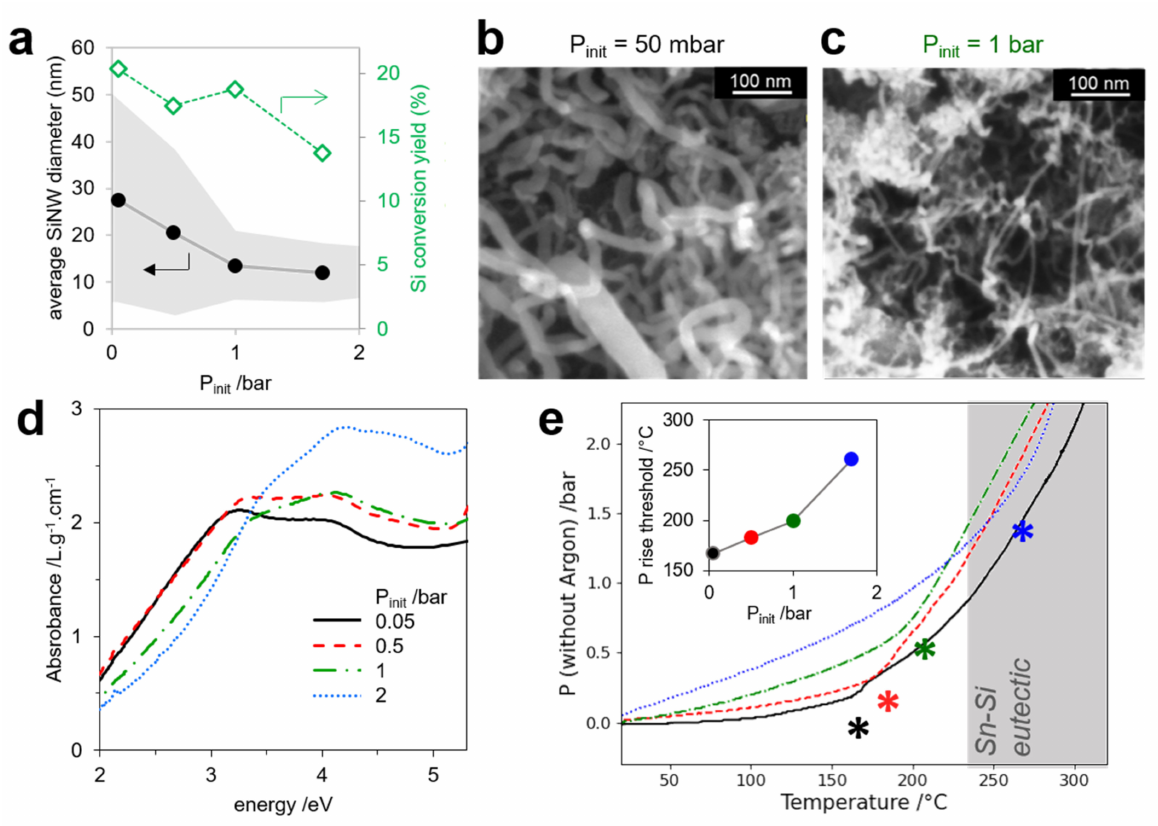
Figure 3. Effect of initial argon pressure P init on SiNW growth: ( a ) average SiNW diameters from SEM (>200 counts) and Si conversion yield vs. initial Argon pressure, P init . ( b , c ) SEM images of SiNWs synthesized with P init 50 mbar and 1 bar, respectively. SEM images and histograms for all samples are shown on Figure S4. ( d ) UV-visible light absorption spectra of SiNWs from SiGt grown with P init 0.05 (black), 0.5 (red), 1 (green) and 2 bar (blue). ( e ) Argon-corrected pressure as a function of temperature for the growth process with P init 0.05 (black), 0.5 (red), 1 (green) and 1.7 bar (blue). The corresponding synthesis parameters are described in entries (3), (7), (8) and (9) in Table S1. Inset: temperature at which the pressure derivative with temperature attains 10 mbar/ ◦ C vs. P init